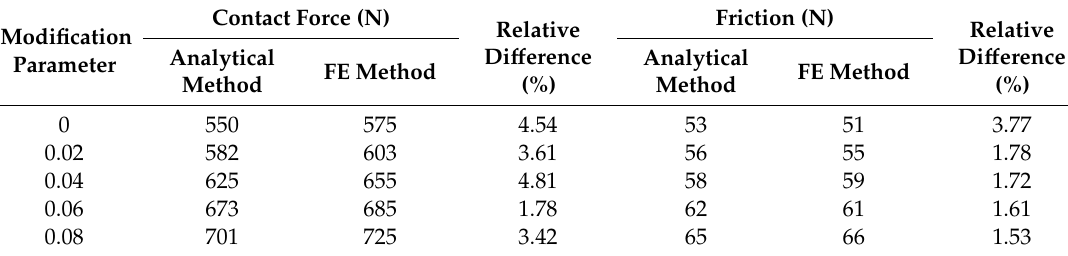
Figure 7. Contact force and friction obtained using analytical (right) and FE (left) methods: ( a , b ) contact force and ( c , d ) friction. Table 2. Percentage of differences between analytical and FE method.